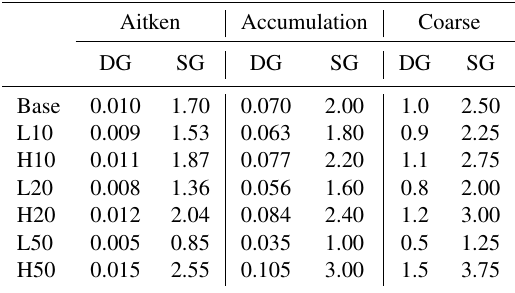
Table 2. DG and SG values in our experiments (DG: µm). Aitken Accumulation